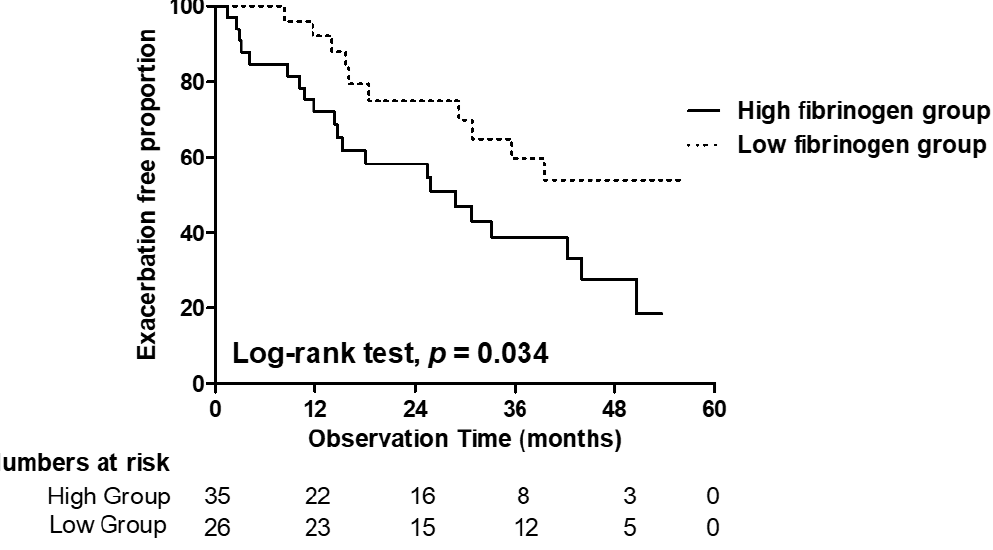
Figure 5. Kaplan–Meier curves for exacerbation-free survival between groups of patients with low Figure 5. Kaplan – Meier curves for exacerbation-free survival between groups of patients with low and high fibrinogen. and high Table 3. Univariate and multivariate Cox proportional hazards model of exacerbation during the Figure 5. Kaplan – Meier curves for exacerbation-free survival between groups of patients with low observation period. and high fibrinogen.